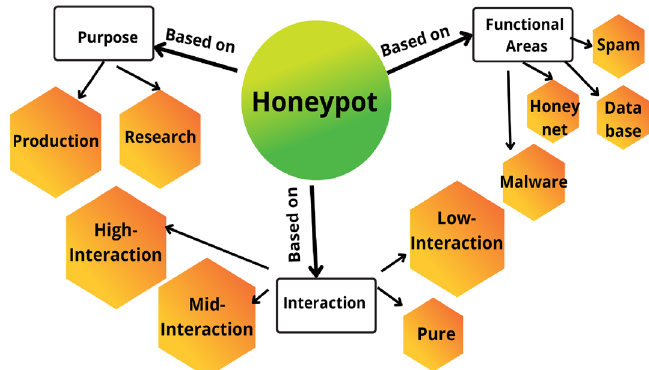
Figure 1. Categorization of honeypot